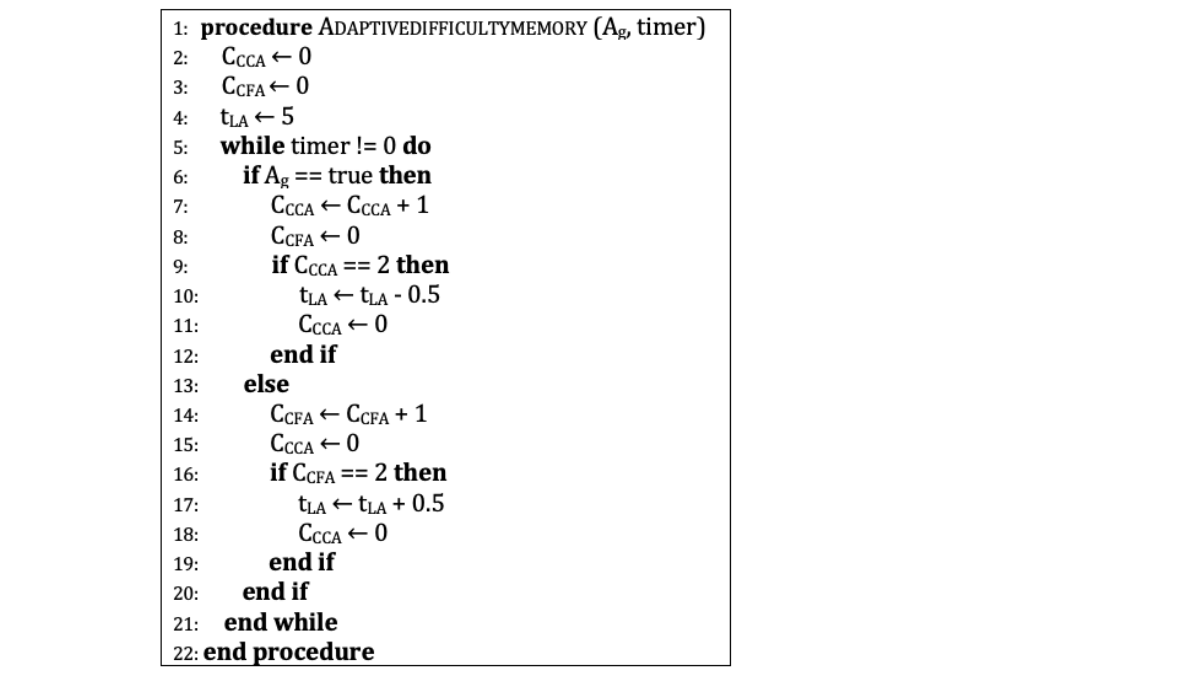
Figure 6. Adaptive difficulty